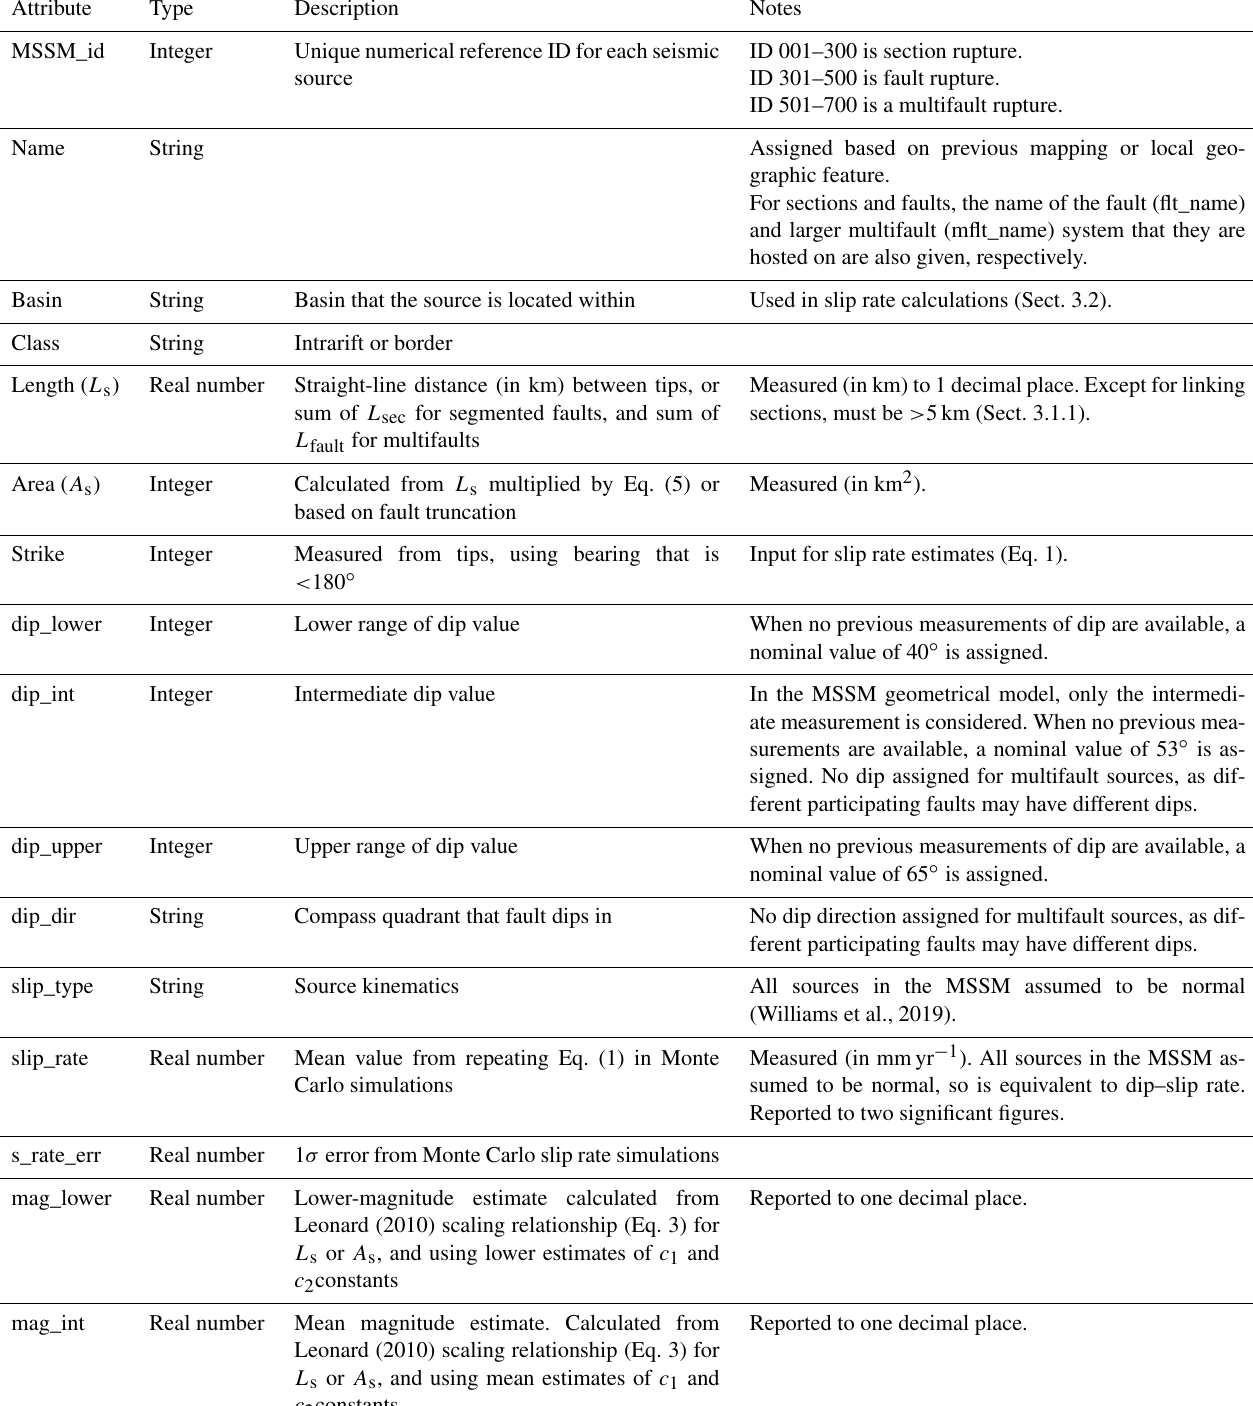
Table 1. List and brief description of fault geometry, slip rate estimates, and earthquake source attributes in the MSSM. Attributes are assigned to each rupture source, with the section, fault, and multifault ruptures stored in distinct